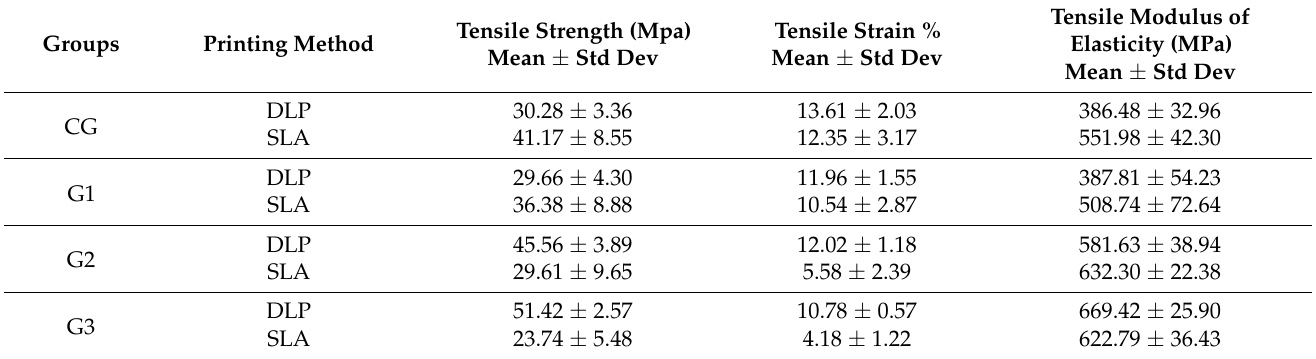
Table 3. Mean and standard deviations of the measured parameters for the specimens during the tensile test.